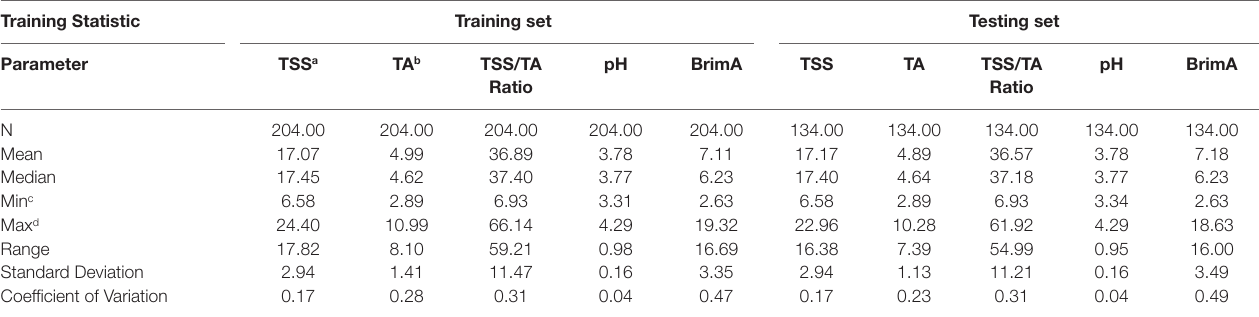
TABle 4 | Statistical analysis of randomly selected training (two thirds of data) and test (one third of data) sets for the combined 2016 and 2017 data sets of the table grape quality parameters TSS, TA, TSS/TA Ratio, pH, and BrimA under study. Training Statistic Training set